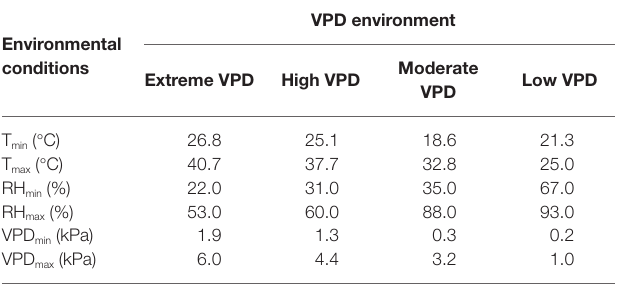
TABLE 3 | Environmental conditions of 4 days with representative VPD